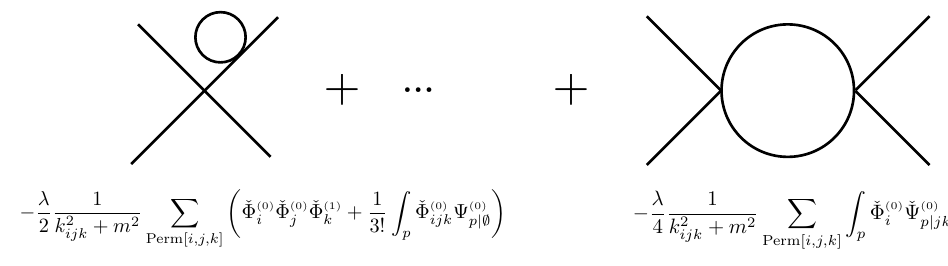
Figure 4 . 1-loop rank-3 off-shell currents that correspond to the 4-point correlation